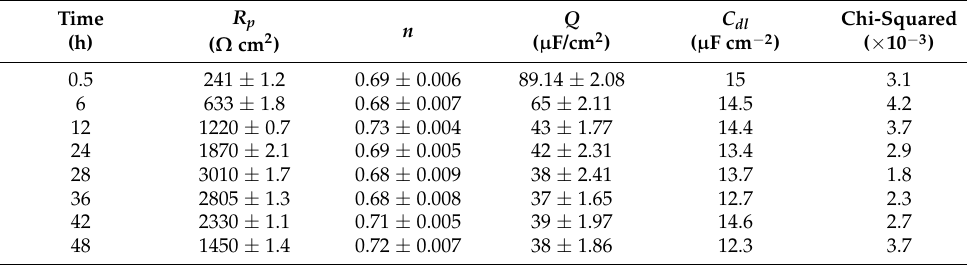
Table 4. Electrochemical parameter values estimated according to EIS curves of N80 steel in 15 wt.% HCl solution in the presence of 5 × 10 − 3 mol/L of MAPEI at 303 K at various immersion